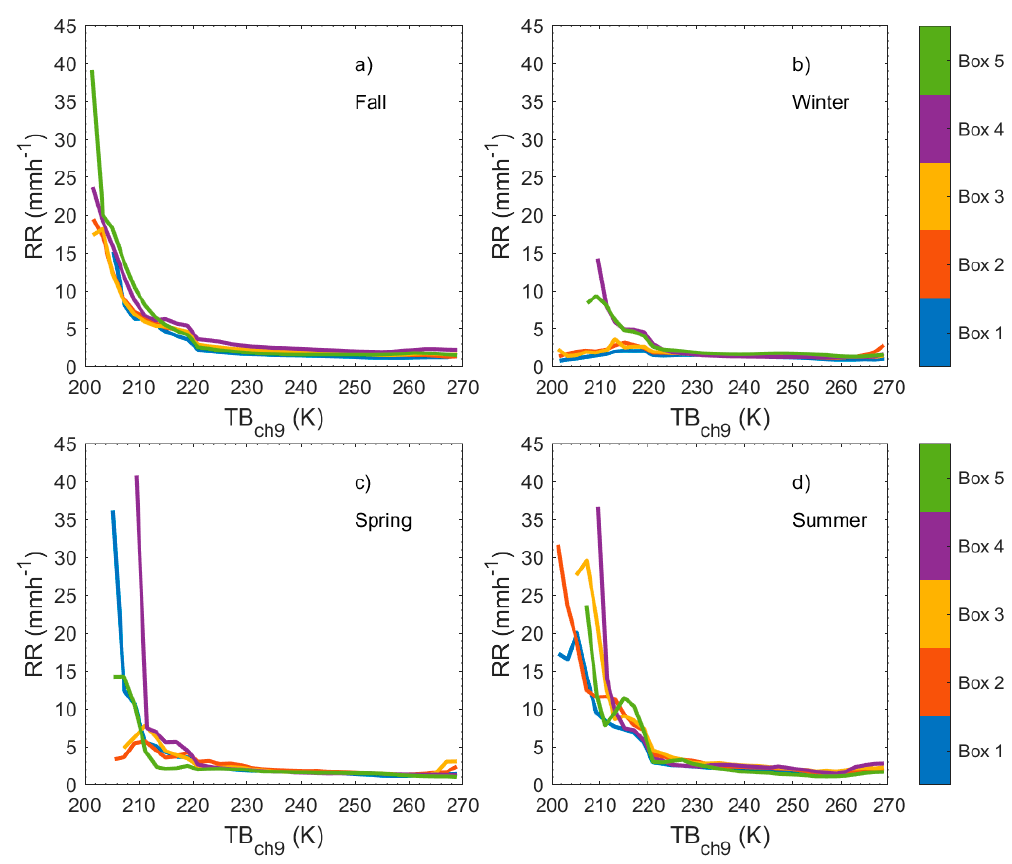
Figure 4. RR-TB 10.8 relationship obtained from the whole dataset (i.e., from 1 July, 2015 to 31 December, 31, 2017) for each box for ( a ) fall, ( b ) winter, ( c ) spring, and ( d ) summer season, respectively.